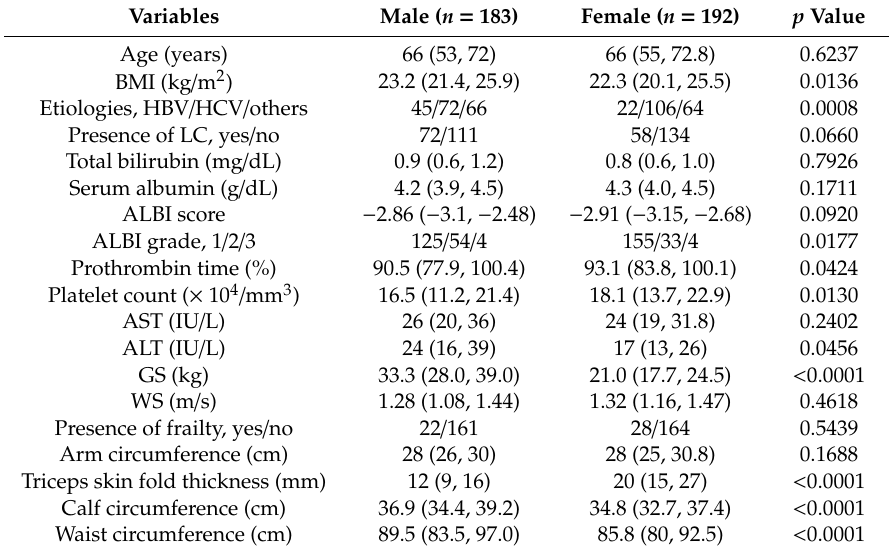
Table 1. Baseline characteristics ( n =